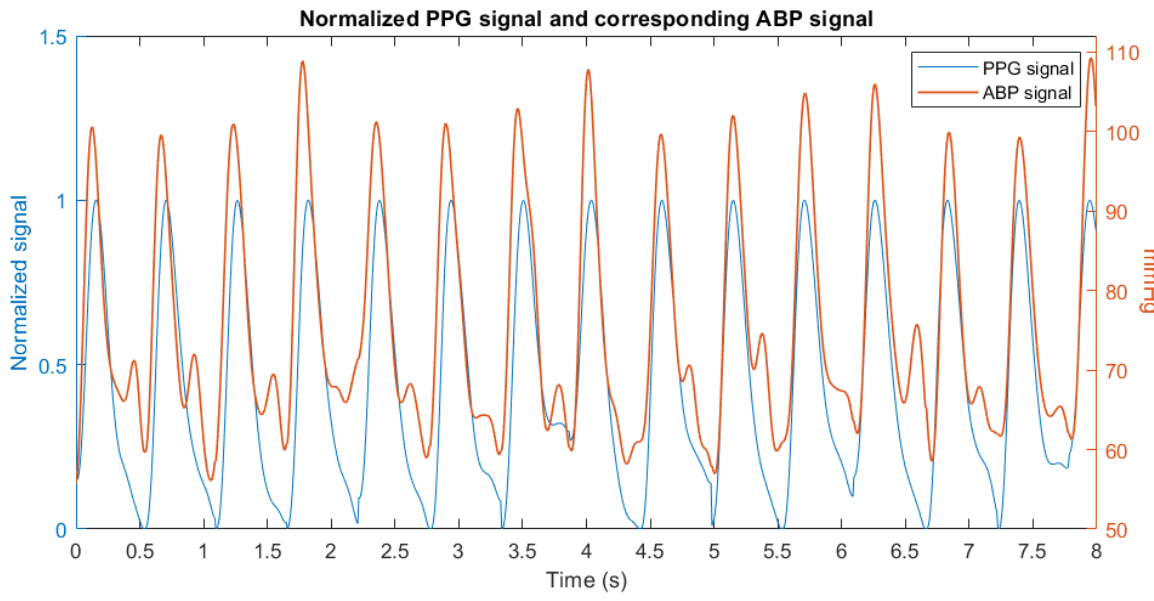
Figure 2. Alignment of the normalized PPG and ABP signals.